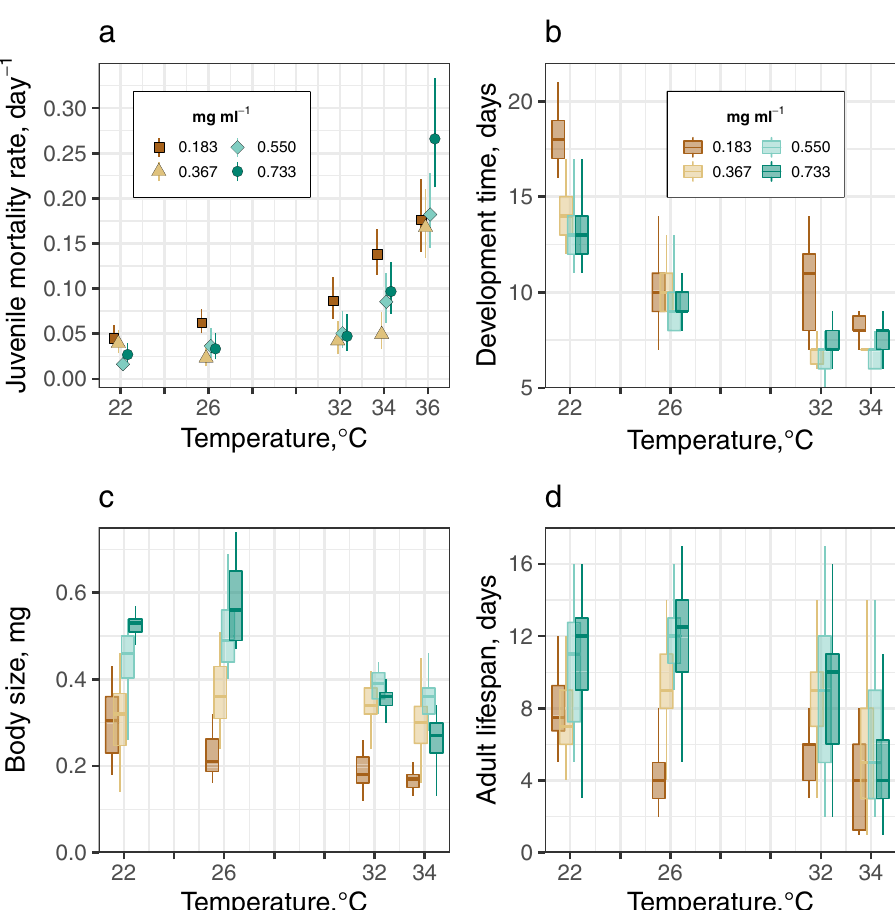
Fig. 1 The effect of larval competition on fi tness traits in Ae. aegypti . a Competition at low resource levels (0.183 mg ml − 1 ) increased the negative effect of increased temperature on juvenile mortality. Symbols with 95% con fi dence intervals denote the predicted mortality rates for each treatment derived from fi tting an exponential function to our survival data using the ‘ fl exsurv ’ 32 R package. b Development time decreased with temperature at all resource levels but, at most temperatures, it was signi fi cantly extended by competition at 0.183 mg ml − 1 . c As temperatures increased from 22 °C, competition at 0.183 mg ml − 1 signi fi cantly reduced size at emergence. d As temperatures increased from 22 to 32 °C, competition at 0.183 mg ml − 1 signi fi cantly reduced adult lifespan. The resulting ANOVAs of the regressions for each trait are presented in Table 1. Boxplot horizontal lines represent medians. Lower and upper hinges are the 25th and 75th percentiles. Upper whiskers extend from the hinge to the largest value no further than 1.5 × inter-quartile range (IQR) from the hinge. The lower whisker extends from the hinge to the smallest value at most 1.5 × IQR of the hinge. The number of female mosquitoes in each treatment is shown in Table 2. Source data are in Supplementary Data